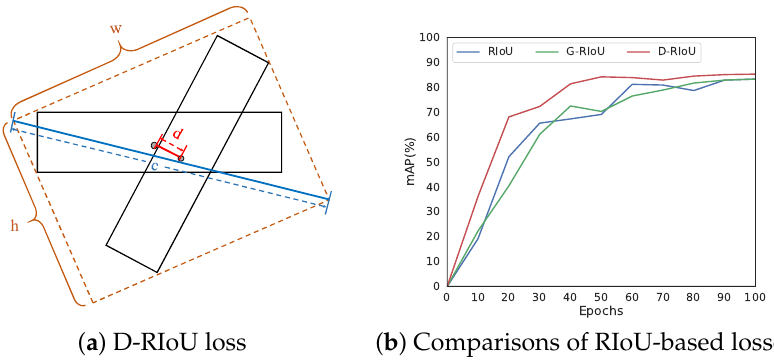
Figure 6. Distance RIoU (D-RIoU) loss for oriented bounding box regression. ( a ) illustrates the detail of D-RIoU. ( b ) shows the performance evaluation of different RIoU-based